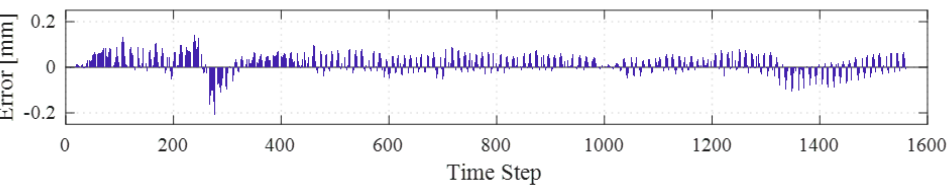
Figure 26. Di ff erence between the exact displacement and prediction calculated at each time step for Model 1a with